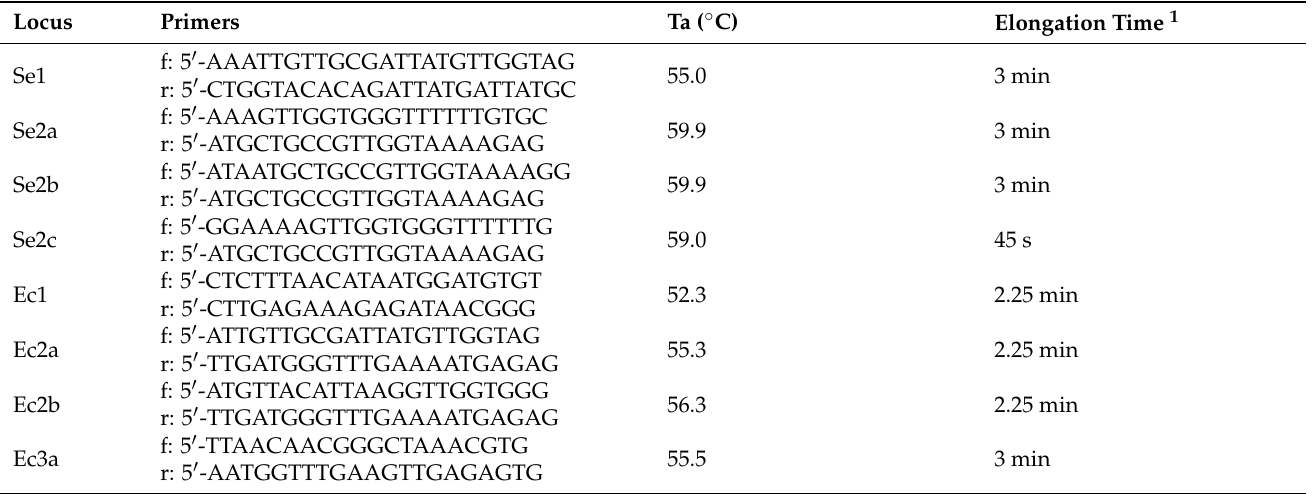
Table 2. PCR primers for CRISPR loci.